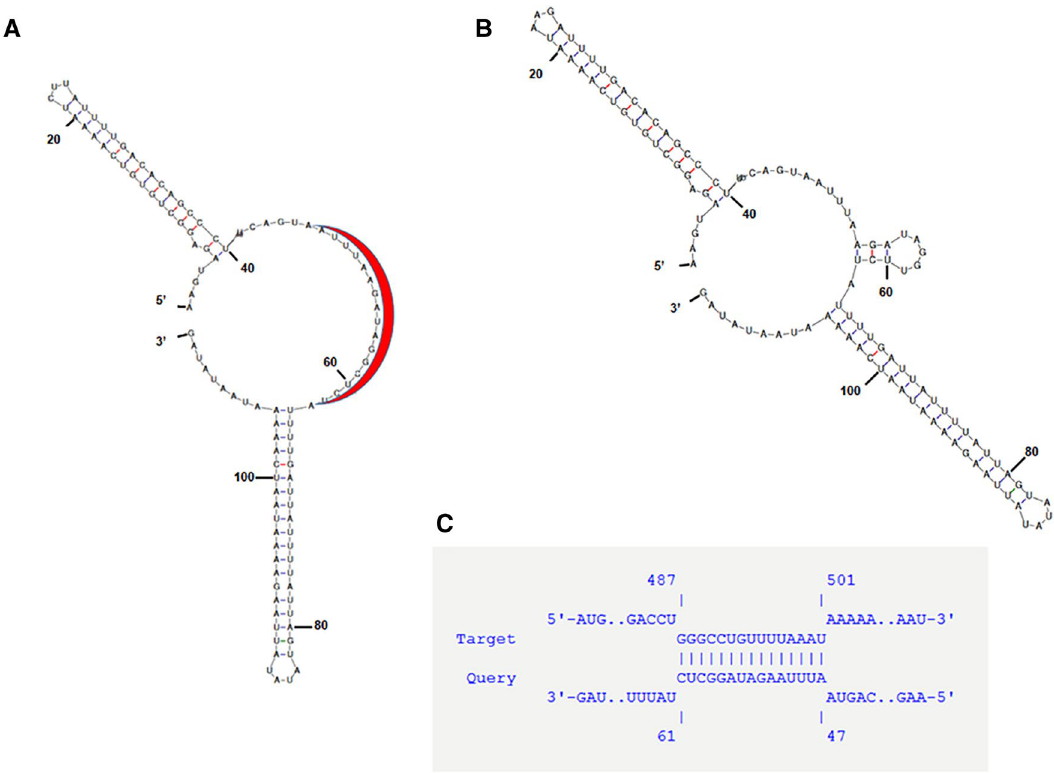
Figure 3. Predicted secondary structure of the putative sRNA of C. tetani and its potential binding site. ( A ) Mfold prediction of the sRNA in most C. tetani clade 1 strains, including the Harvard derived strains. The red arc represents the potential binding site with tent. The stem-loop that is most distant from tent contains a Rho-independent terminator, according to an ARNold analysis. ( B ) Mfold prediction of the sRNA from C. tetani clade 2 and 1G strains. ( C ) A nearly perfect 14 nt match of the interior junction-loop-exposed sequence (nucleotide positions 47–61) of the sRNA with the 5 ′ end of tent mRNA (nucleotide positions 487–501 of tent ) was detected. The image was created with mfold (v3.5; http://www.unafo